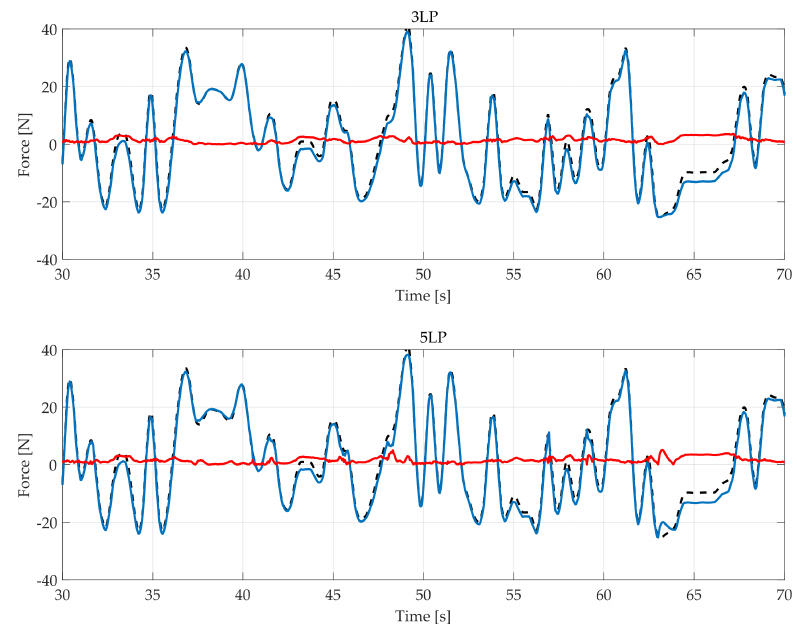
Figure A5. Detailed view of the time response shown in Figure 12 for each model.